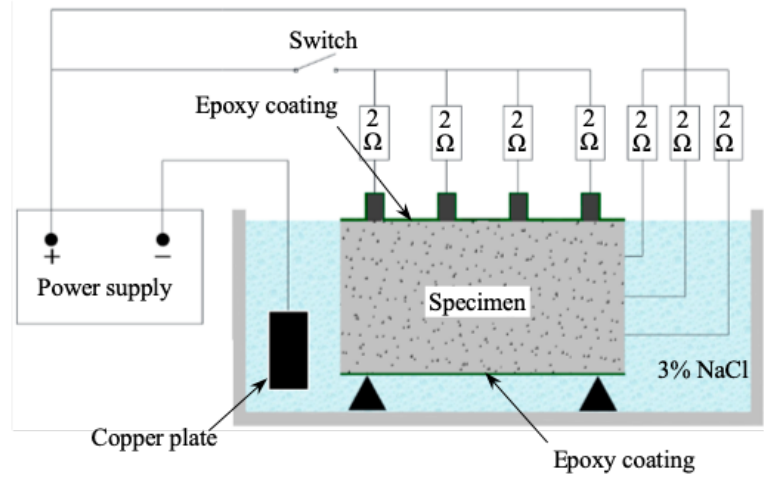
Figure 2. Accelerated corrosion test method.